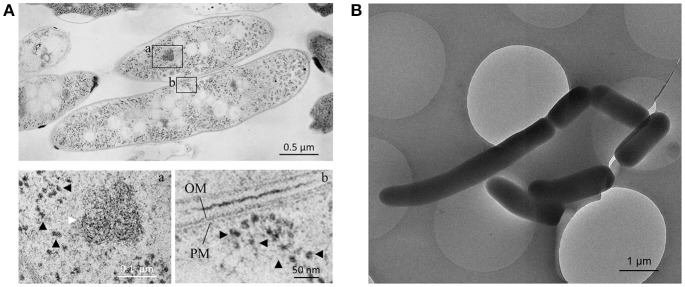
Images of ultrathin section and cryo-transmission electron microscopy (TEM) of M. smegmatis cells. (A) Two M. smegmatis cells processed through rapid-freeze and freeze-substitution in an ultrathin section. (a,b) enlarged images of the selected field of view in (A). (a) Condensed DNA fiber (white arrow) and ribosome particles (black arrowhead). In (b) Ribosome particles (black arrowhead) and plasma membrane (PM) and outer membrane (OM). (B) CryoTEM image of M. smegmatis cells with varied cell lengths.